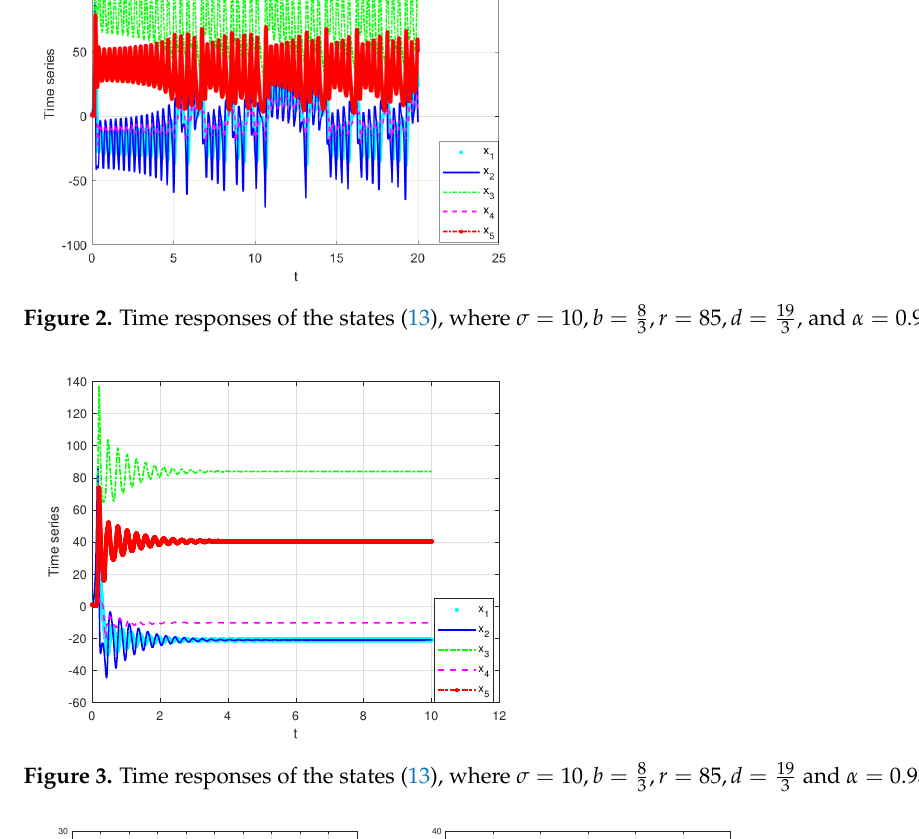
Figure 3. Time responses of the states (13), where σ = 10, b = 8